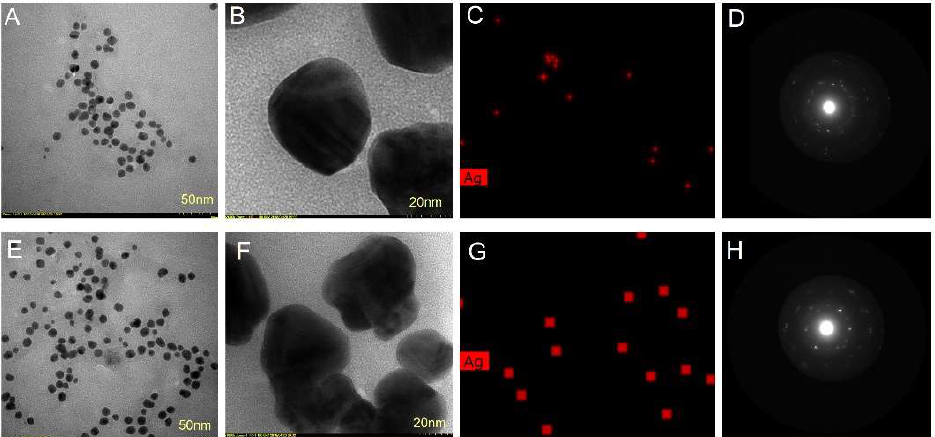
Figure 7. Picea abies bark extract derived AgNPs: TEM micrographs ( A , B ), TEM-EDX mapping ( C ) and SAED pattern ( D ); Pinus nigra bark extract derived AgNPs: TEM micrographs ( E , F ), TEM-EDX mapping ( G ) and SAED pattern ( H ).